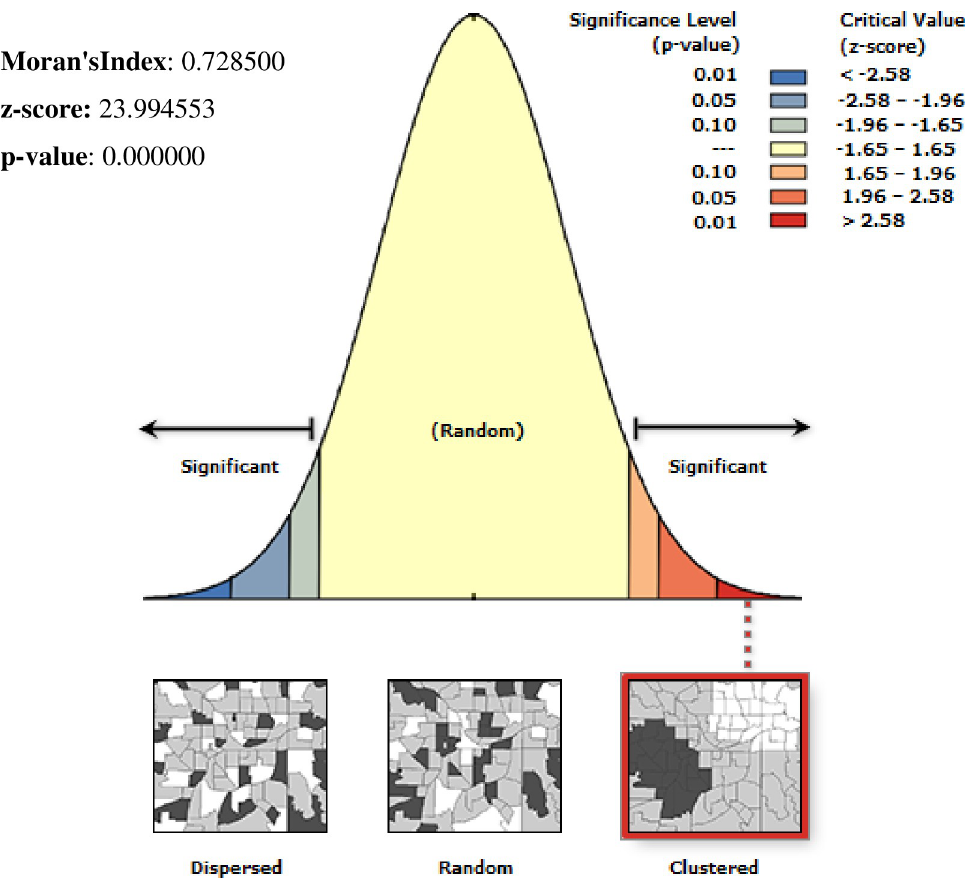
Fig 1. Spatial autocorrelation of limited water service among households in Ethiopia, EDHS 2016, shapefile from 2018 GADM and plotted using ArcMap version 10.7